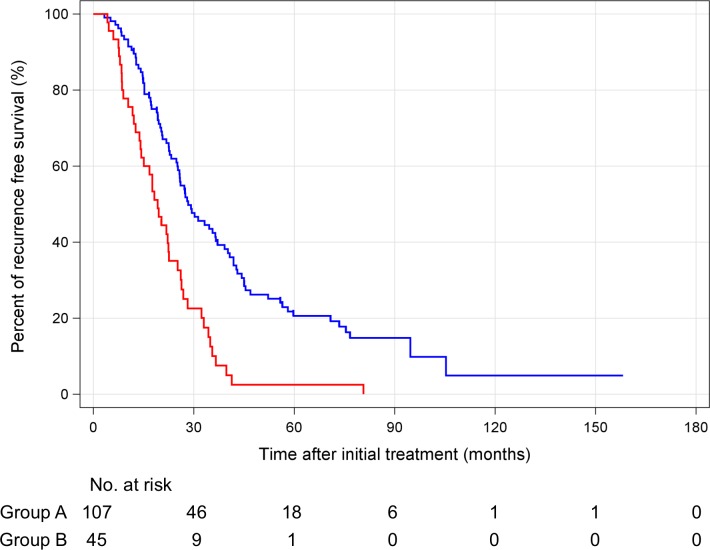
Kaplan-Meier curve recurrence free survival curves for hypervascular hepatocellular carcinoma only (group A, blue line) and hypovascular nodules co-existing with hypervascular hepatocellular carcinoma (group B, red line).